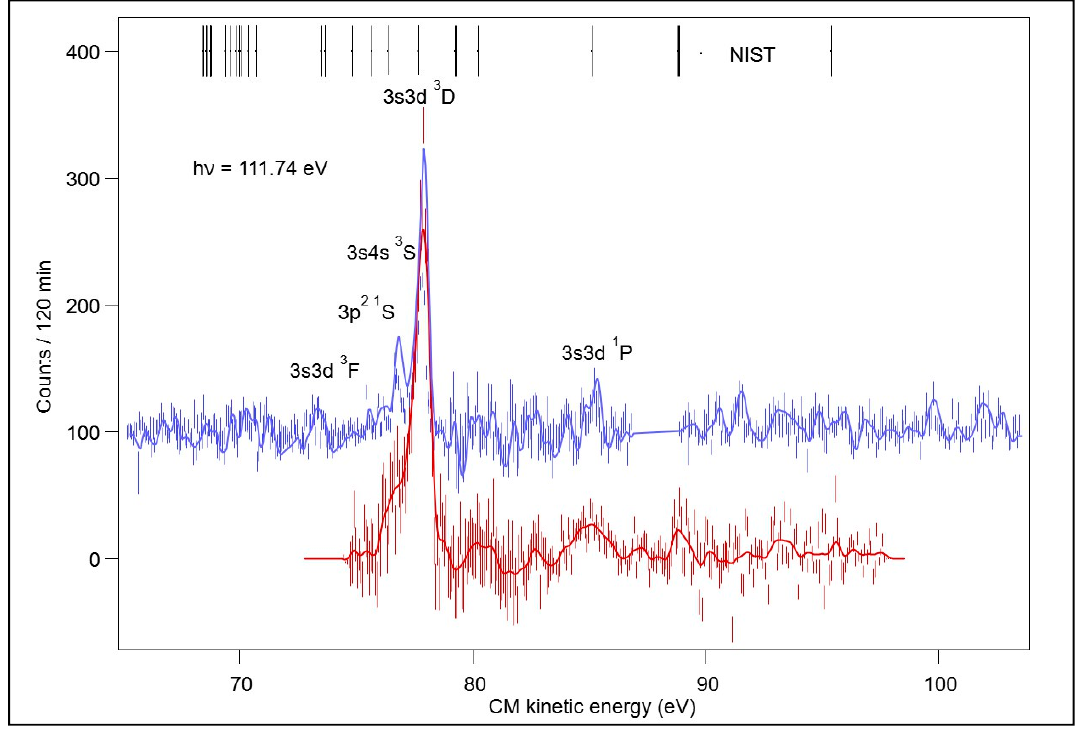
Figure 6. Electron spectra on Si + 2p → 3d 2 D 5/2 resonance (two different energy scans). The black lines correspond to the energy levels from NIST for Si 2+ [28] .